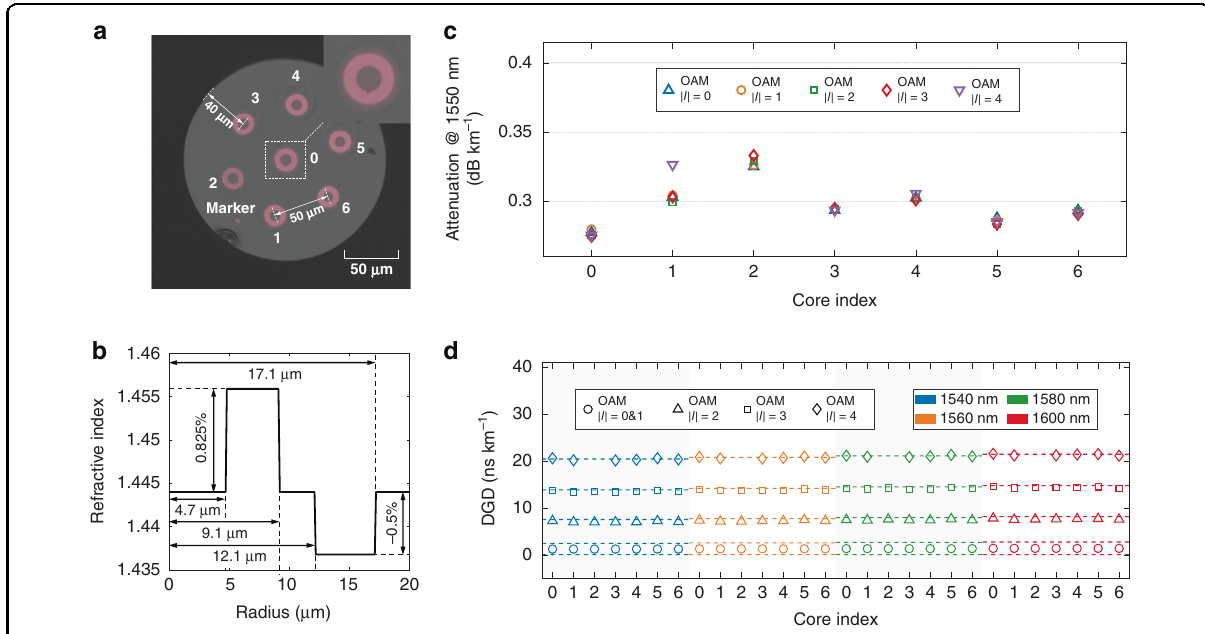
Fig. 4 The characteristics of the 34 km 7-core RCF. a The cross-section diagram; b The refractive index pro fi les; c The measured mode dependent attenuation of 7-core RCF at 1550 nm; d The measured and simulated DGD at 1540, 1560, 1580, and 1600 nm of the designed fi bre (dashed lines represent the simulated results). One averaged DGD value is given for OAM MGs | l | = 0 & 1 in the measured results, as their impulse response merged into one Gaussian-distribution peak due to strong coupling between these two MGs after 34 km